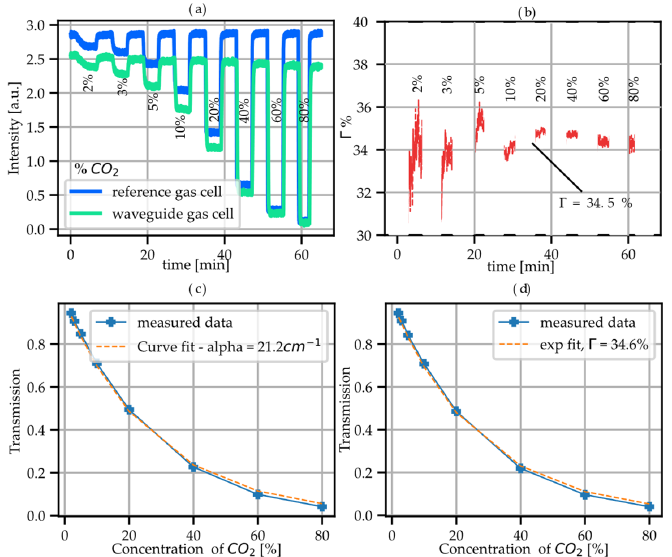
Figure 5. Exemplary experimental measurements of Γ , taken from waveguide A. ( a ) Measured transmission through the waveguide and the reference gas cells for different CO 2 concentrations. ( b ) Extraction of Γ according to Equation (6). ( c ) Estimation of the effective absorption coefficient of CO 2 ( α ef f ) from Equation (5). ( d ) Extraction of Γ by fitting measured data by Beer–Lambert function Equation (4), using the effective absorption coefficient derived in ( c